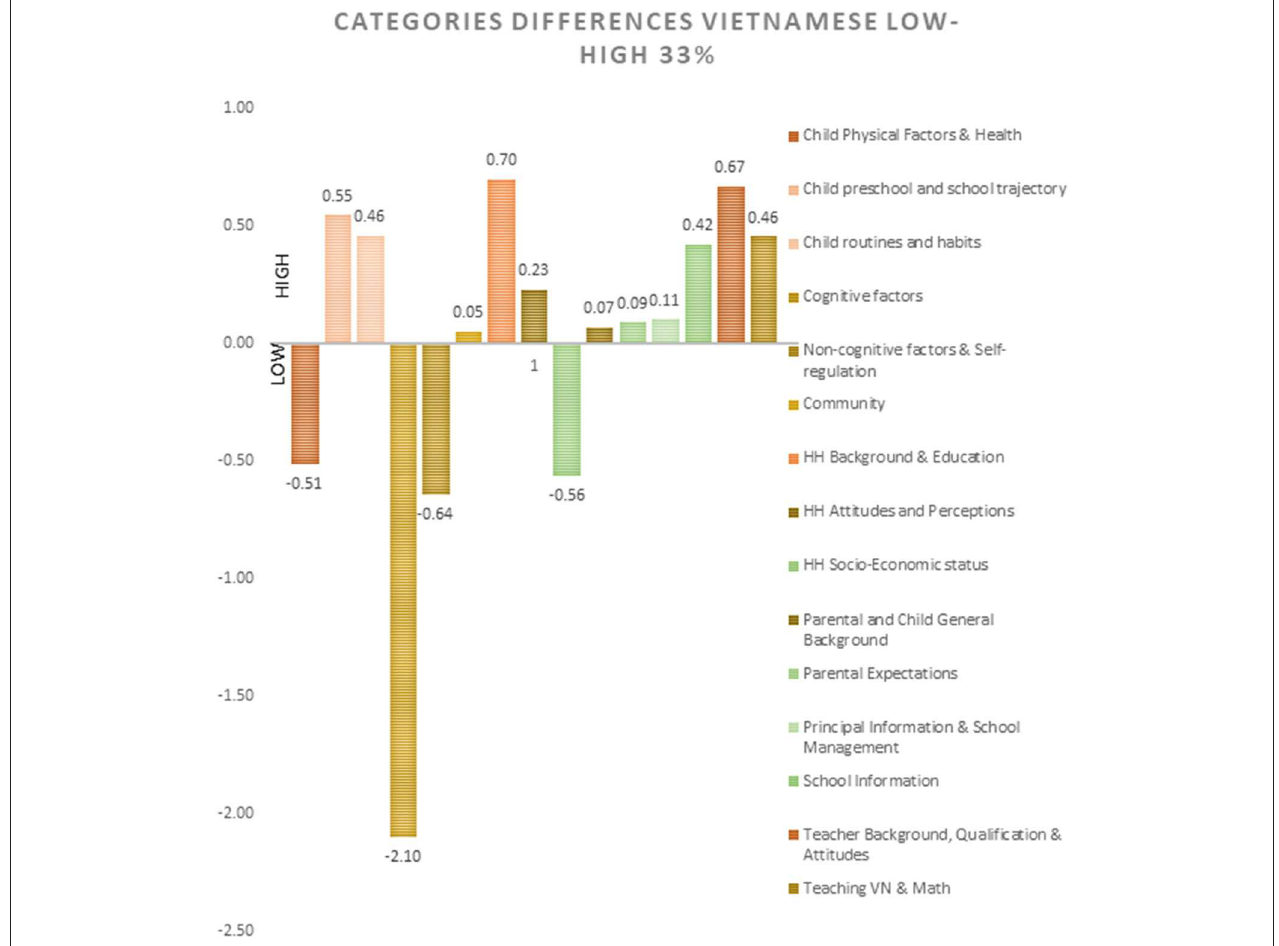
FIGURE 7 | Differential contribution of each category of variables for each vietnamese performance level, according to the observed predictive weight.